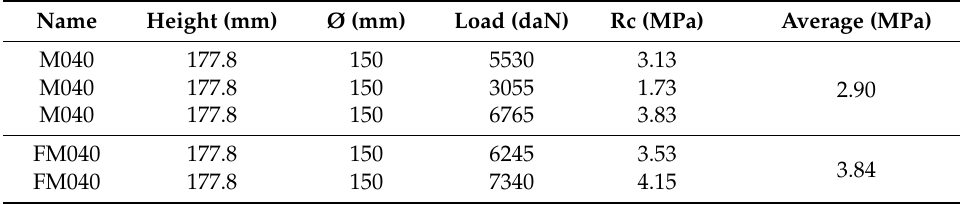
Table 3. Unconfined compressive strength (UCS) results.